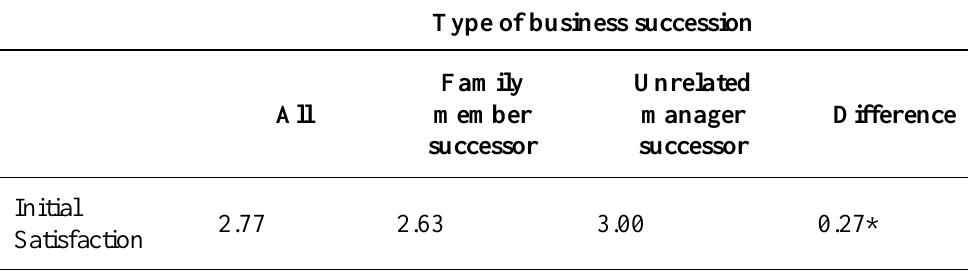
Table 3: Initial satisfaction with the business succession